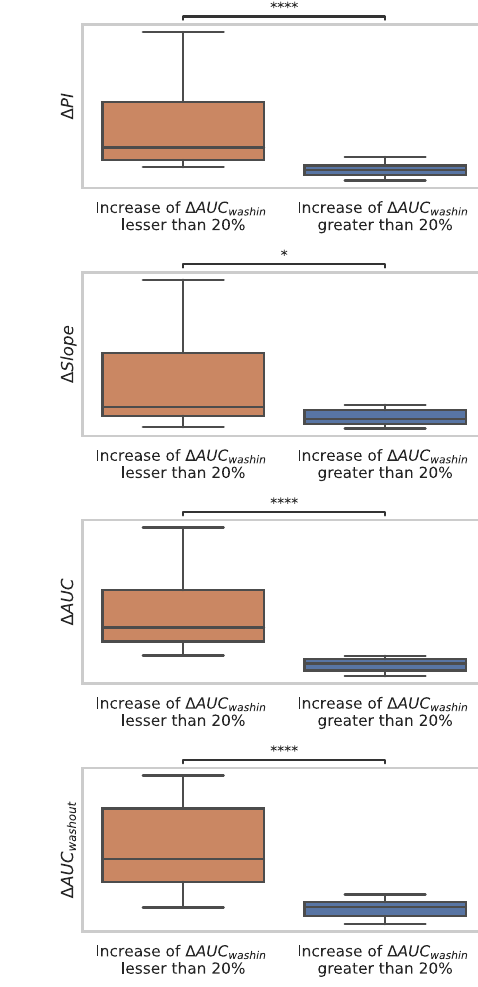
lesser than 20% (=25